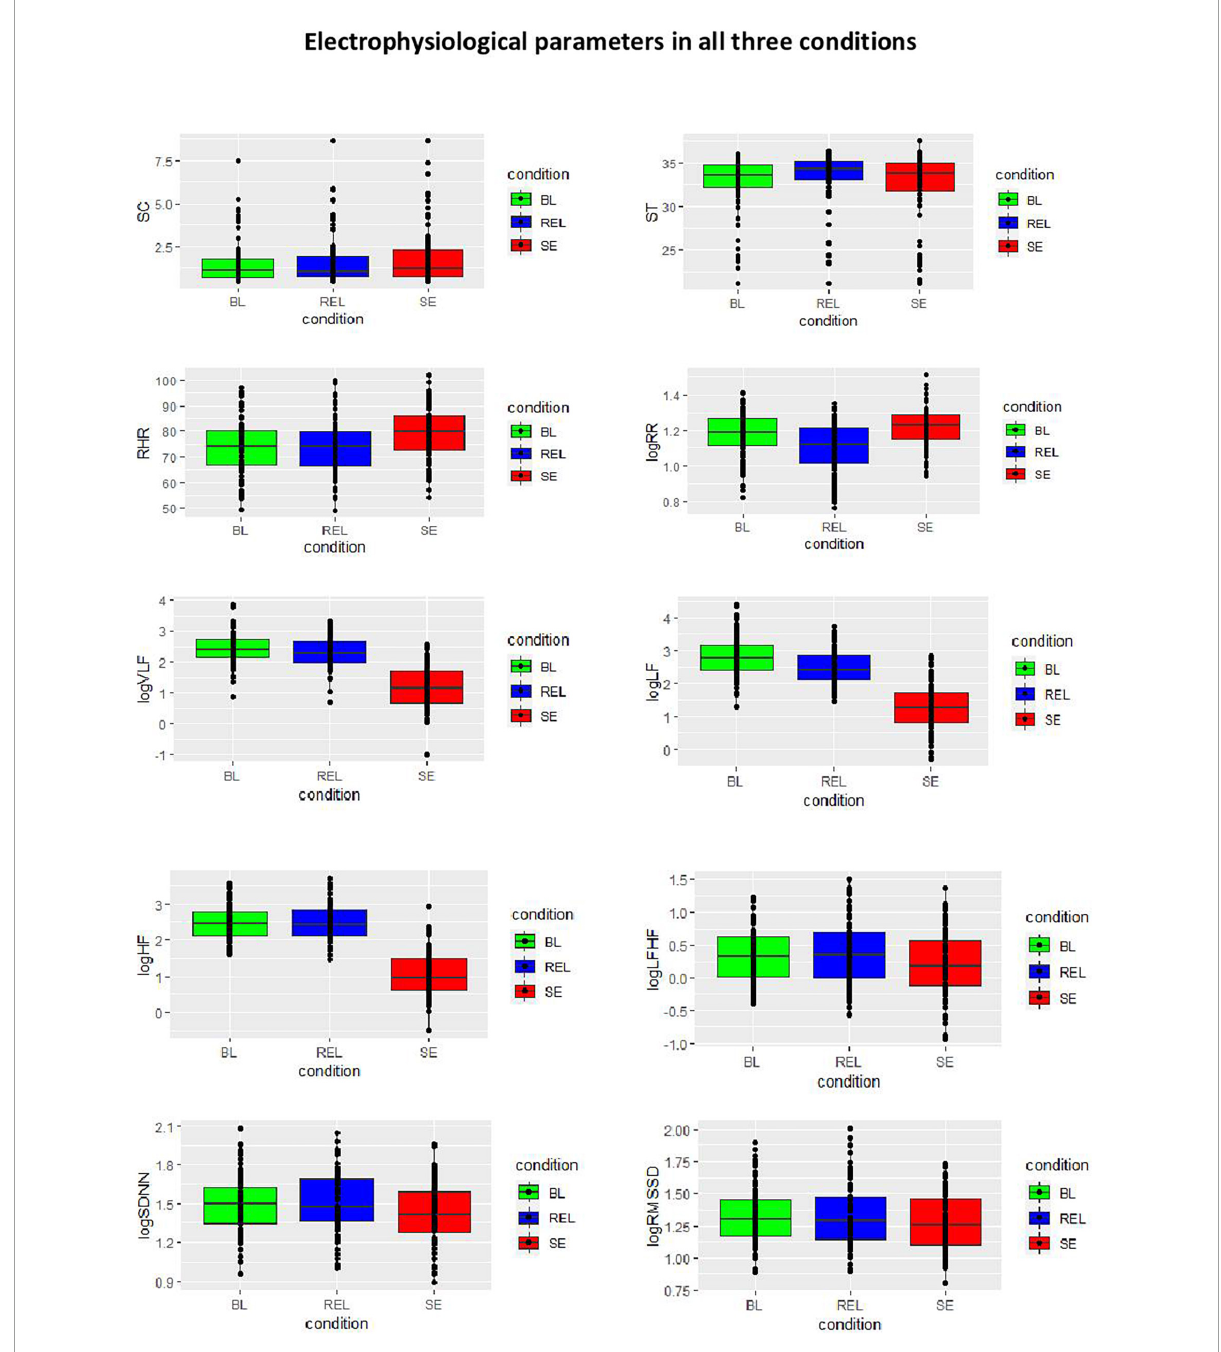
FIGURE1 Electrophysiological parameters in all three conditions. SC, skin conductance; ST, skin temperature; RHR, resting heart rate; RR, respiration rate per minute; HRV, heart rate variability; SDDN, standard deviation of beat-to-beat intervals; RMSSD, root mean square of successive differences; VLF, very low frequency; LF, low frequency; HF, high